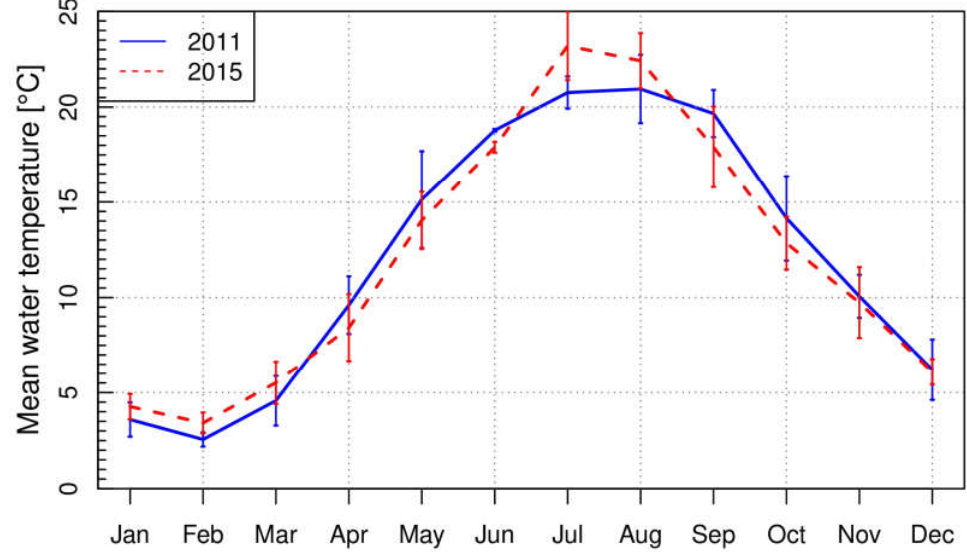
Figure 2. Monthly mean water temperature and standard deviation at Lake Starnberg in 2011 and 2015.